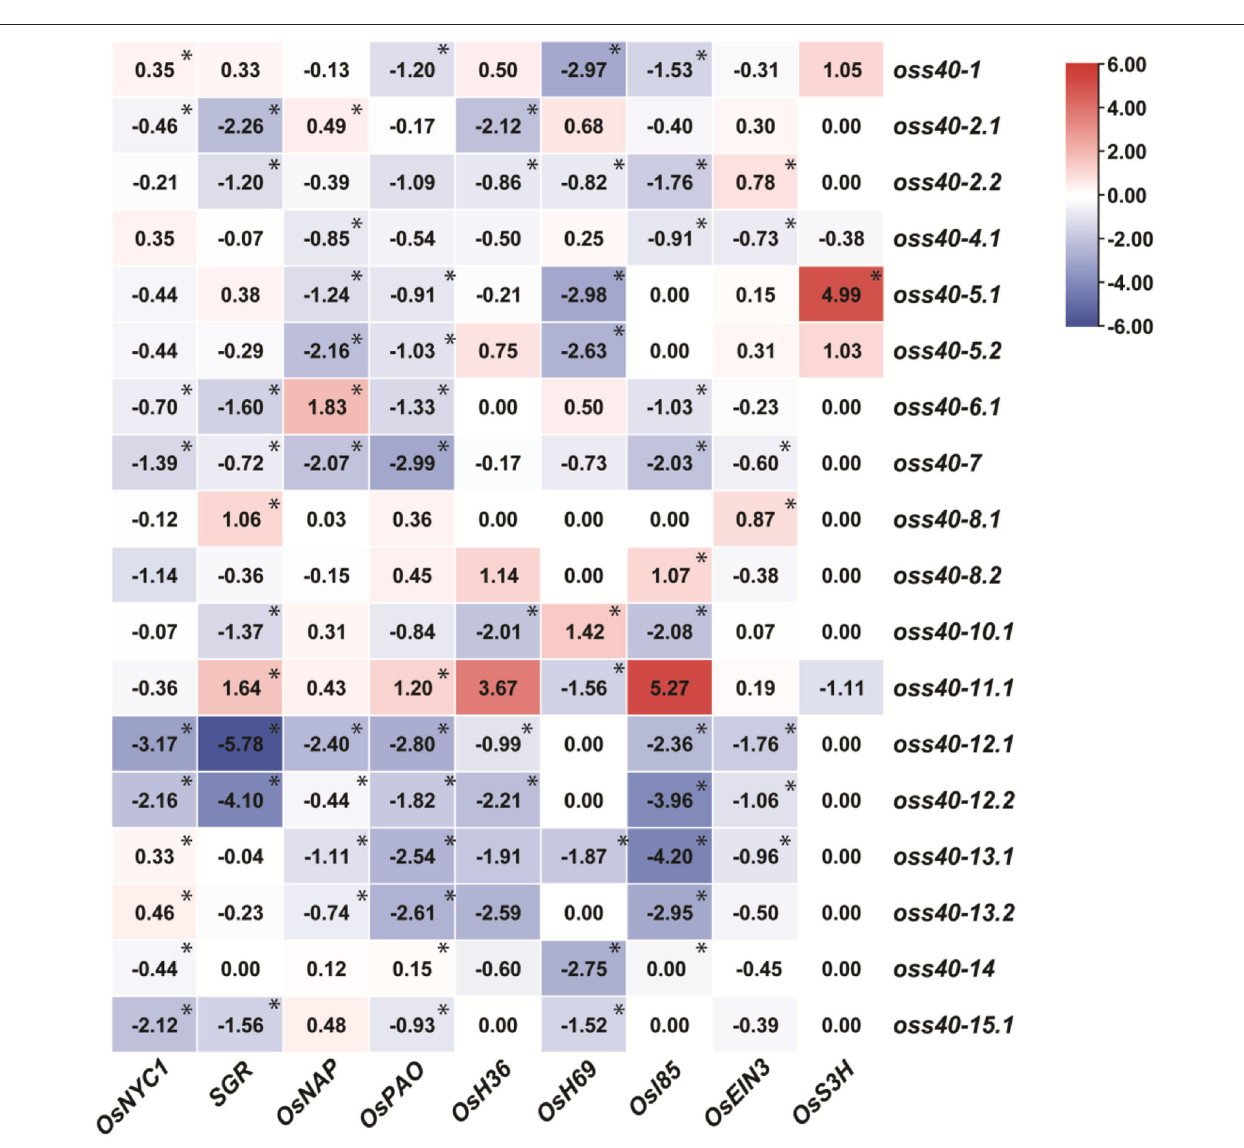
Altered Expressions of OsWRKY